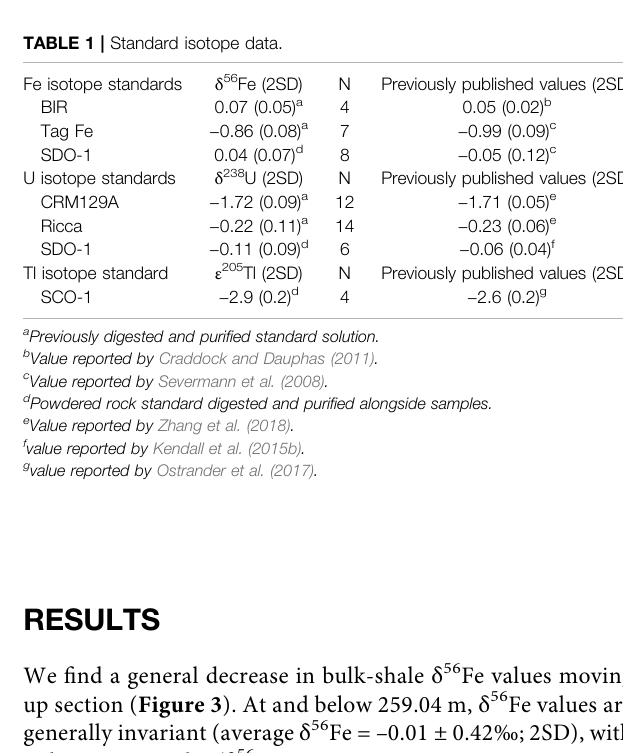
Frontiers in Earth Science |